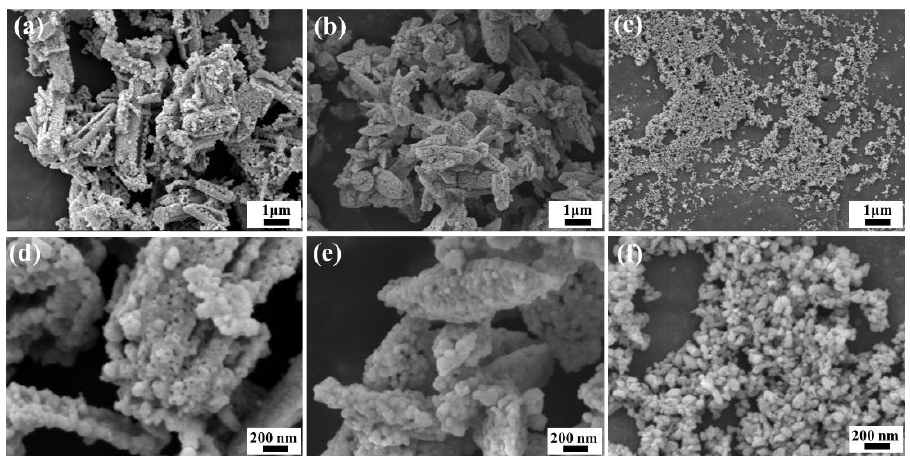
Figure 4. SEM images of ceria-based abrasives. ( a , d ): F-abrasives; ( b , e ): S-abrasives; ( c , f ): N-abrasives.